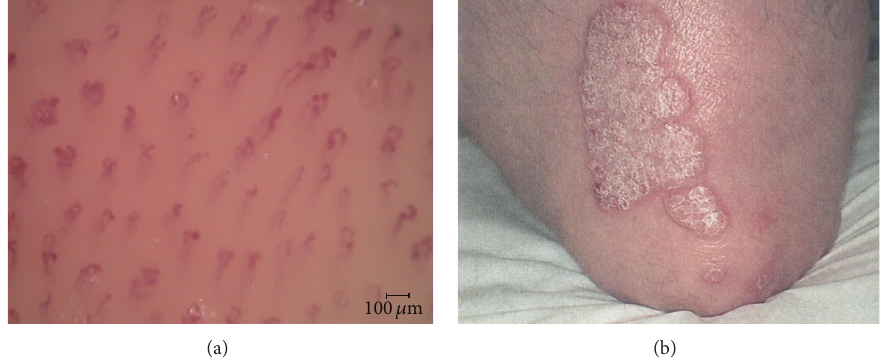
Figure 1: Capillaroscopic image (a) of the centre of the psoriatic plaque (b) at T0.